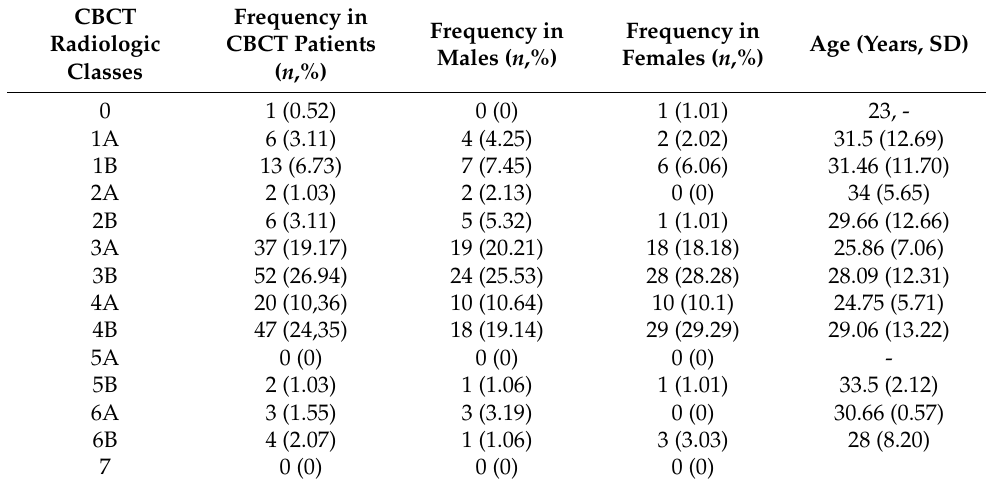
Table 3. Distribution of radiologic classes according to Maglione et al. 2015, in the sample of Cone Beam Computed Tomography (CBCT)